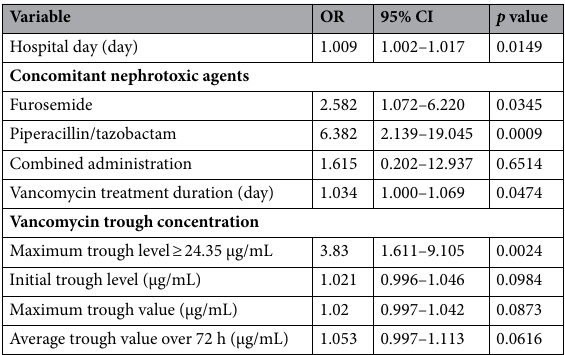
Table 3. Univariate logistic regression analysis of independent risk factors for VIN. VIN vancomycin-induced nephrotoxicity, OR odds ratio, CI confidence interval, BUN blood urea nitrogen. Continuous variable odds ratio is odds per single unit indicated in